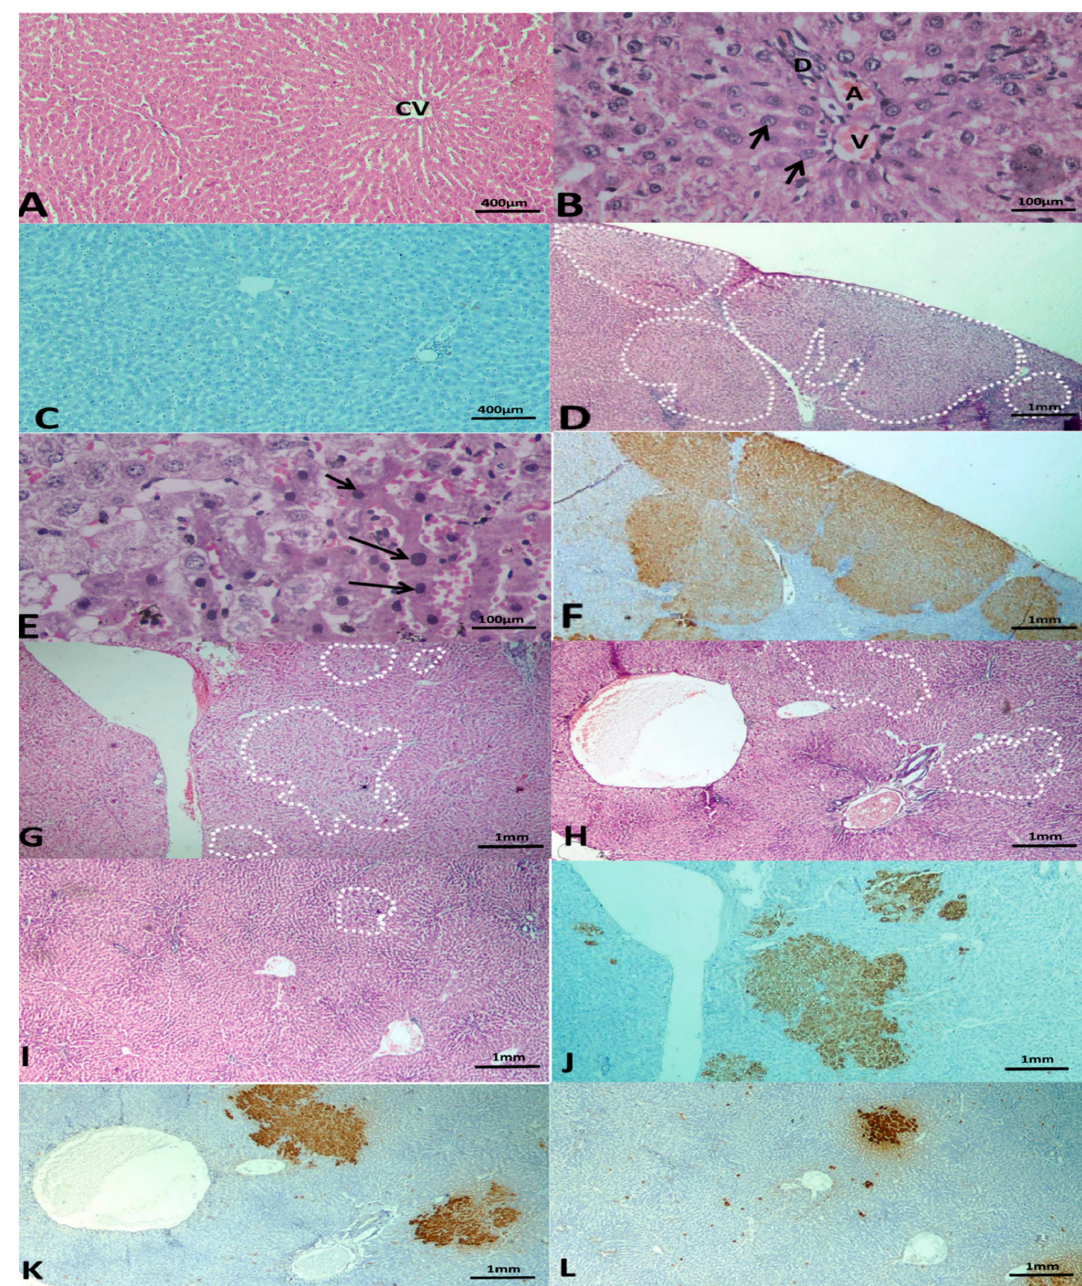
Figure 2. Photomicrographs of liver tissues after 112 days. ( A ) Normal control group with H & E stain showing normal hepatic architecture. ( B ) Normal control group with H & E stain showing polygonal hepatocytes (arrows) with central rounded vesicular nuclei, and a portal triad formed of a branch of the portal vein (V), bile ductile (D), and branch of the hepatic artery (A). ( C ) Normal control group with the immuno-histochemical stained section with Anti GST-P showing a negative reac- tion. ( A ) × 100 Hx & E stain, ( B ) × 400 Hx & E stain, ( C ) × 100 anti GST-P immuno-histochemical stain. ( D ) Group 2 treated with DEN and 2-AAF stained with H & E. Liver section showing larger, less discriminated dysplastic nodules compressing the surrounding liver tissue with disruption of normal hepatic lobular architecture (dotted shapes). ( E ) Group 2 treated with DEN and 2-AAF stained with H & E showing dysplastic alternating hepatocytes and dark hyper-chromatic nuclei and increased nuclear-cytoplasmic ratio (arrows). ( F ) Group 2 treated with DEN and 2-AAF with immuno-histochemical stained sections with GST-P antibody showing large multiple